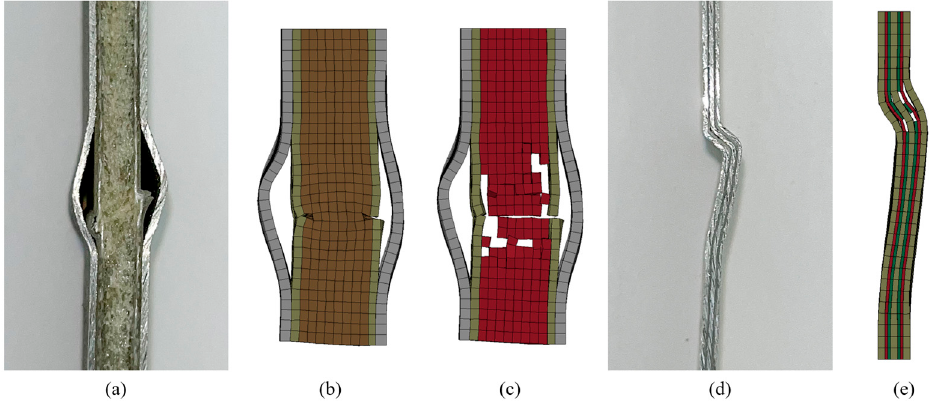
Figure 19. Compression failure mode for virgin specimens: ( a ) actual 3DFML; ( b ) numerically pre- dicted 3DFML; ( c ) numerically predicted pillars’ failure for 3DFML; ( d ) actual GLARE; ( e ) numerically predicted GLARE.